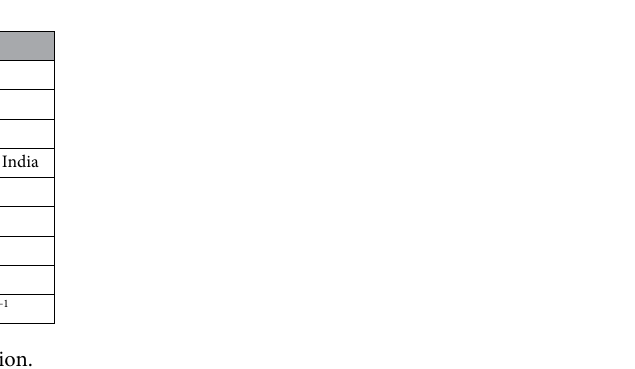
Table 3. BTPSD properties and